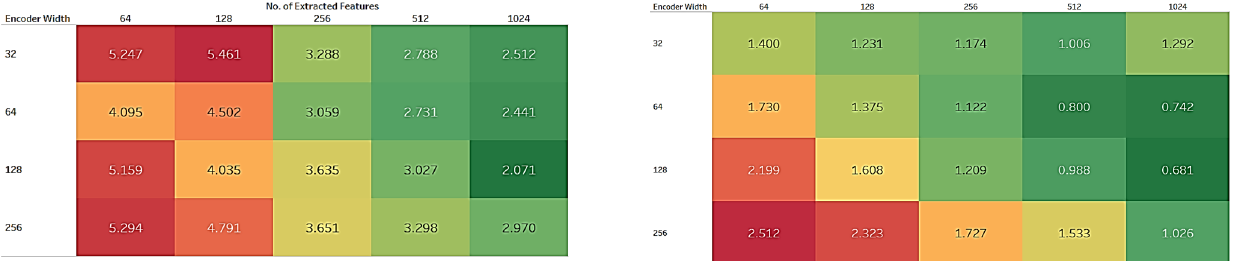
Figure 5. Heatmap depicting MAE for SBP ( left ) and DBP ( right ) prediction while varying encoder width and number of extracted features. Here, the color scale varies from red (high performance) to green (low